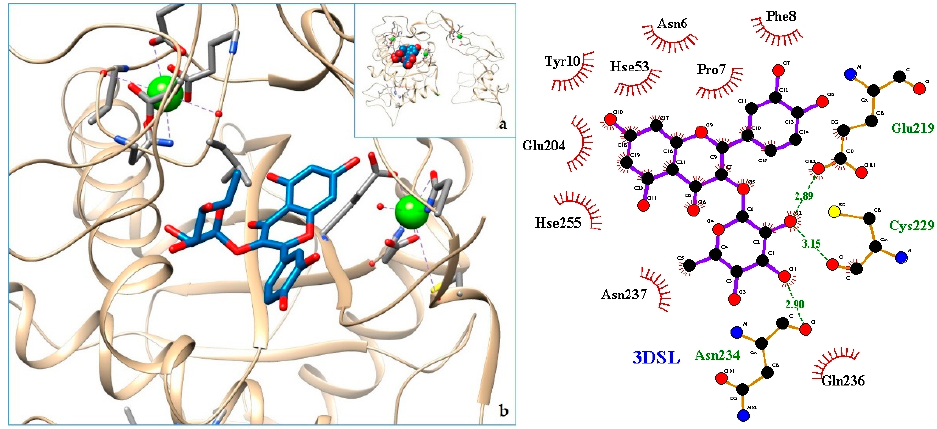
Figure 14. 3DSL-quercetrin complex in the most favourable arrangement ( a ) and augmented ( b ) showing the disposition between the chain of toxins. Right: 2D interaction diagram.